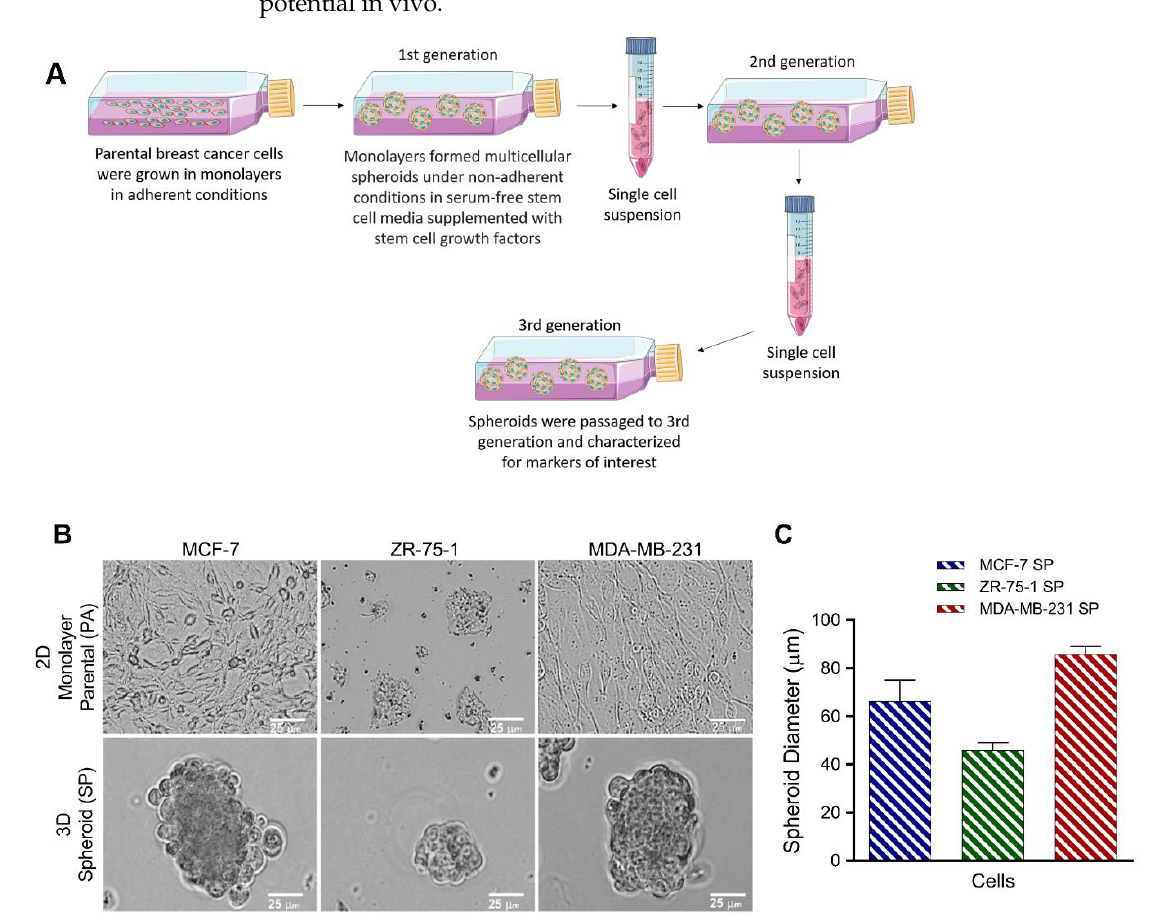
Figure 1. Generation of 3D multicellular breast cancer spheroids. ( A ) Human breast cancer cell lines were cultured in non- adherent conditions at a density of 5 × 10 6 cells/mL in 75 cm 2 agarose-coated cell culture flasks in serum-free RPMI-1640 medium supplemented with stem cell growth factors (30 ng/mL of bFGF, 30 ng/mL of EGF, 4 ng/mL of insulin, 0.5% BSA, and 0.03% B27, as previously reported [23,28]). Once spheroids started to form, the growth factor-supplemented culture medium was replaced every other day. For passaging, 0.05% trypsin was added to the cells and gently centrifuged, and the pellet was gently dissociated with a blunt-end 16-gauge needle into single-cell suspensions. This process was repeated to obtain 3rd generation passage of 3D multicellular spheroids compared with the 2D monolayer cell cultures. 2D monolayer cells and 3D 3rd generation spheroids were visualized under phase microscopy (scale bar = 25 µm). ( B ) Morphology 2D monolayer parental cells and 3rd generation 3D spheroids cultured in stem cell factor-supplemented culture medium.